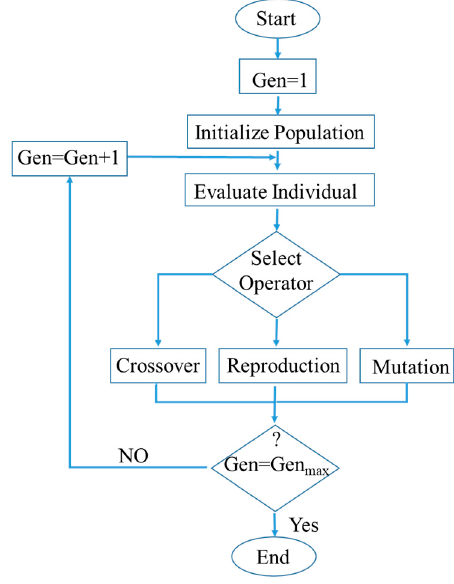
Figure 3. Computation flowchart of genetic programming (GP).